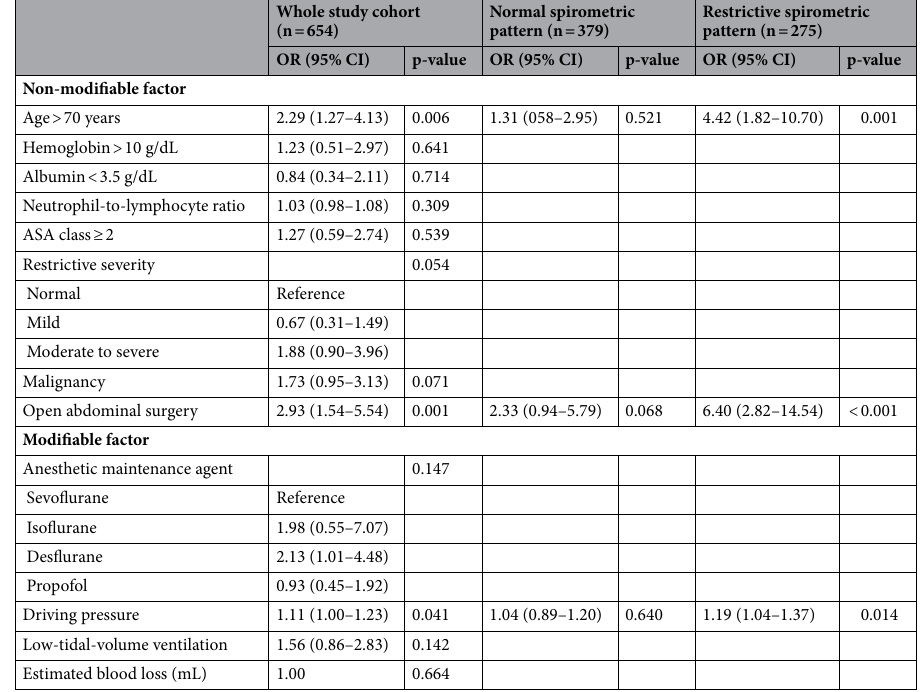
Table 2. Multivariable analysis for the whole study cohort and the subgroups stratified by preoperative spirometry. Multivariable analysis was performed using the entry method including 12 variables with p of < 0.2 in univariate analysis. Static compliance was not included in the multivariable analysis process due to mathematical connection to the driving pressure. Subgroup analysis was performed by logistic regression including the three co-variables confirmed to be significant in the final multivariable model for the whole study cohort (age, open abdominal surgery, and driving pressure). Type of surgery was included in the multivariable analysis as a dichotomous variable (open abdominal surgery or other surgeries).